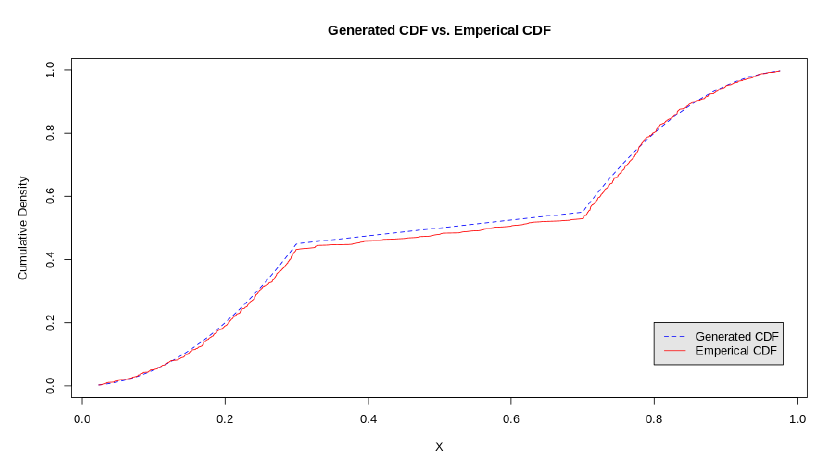
Figure 4. Graphical illustration of the KS Test for bimodal univariate